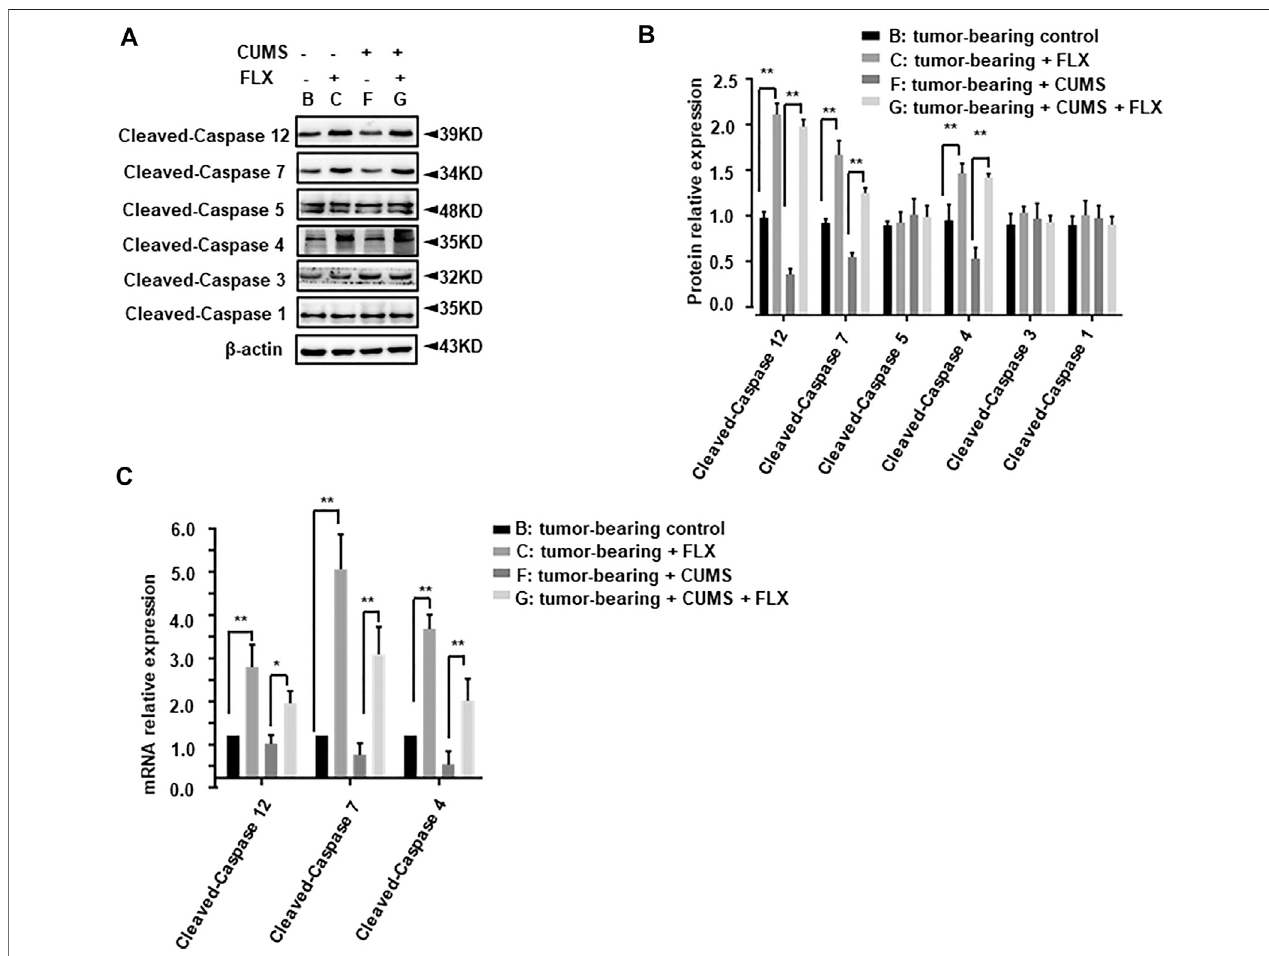
FIGURE8| Effectof fl uoxetineonimmunerelatedpro-apoptosisgenesintumorbearingmice. (A,B) Representativeandstatisticalanalysiswesternblottingbands of tumor in mice. (C) mRNA relative expression of tumor bearing mice. Data were expressed as mean ± SD. ** p < 0.01.